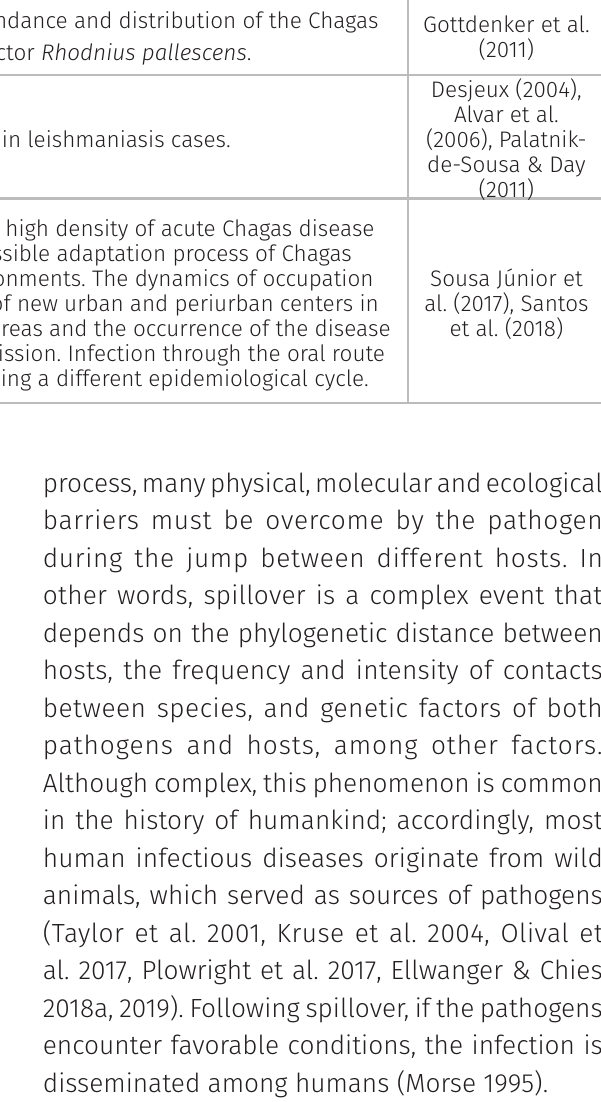
Fluctuation of prices of commodities, migrations and ecological impacts.